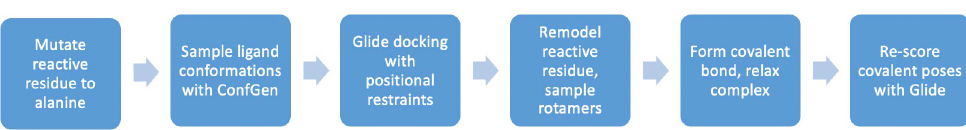
Fig 1. Schr¨odinger’s CovDock workflow for covalent docking, adapted from Schr¨odinger’s documentation (release 2020–1).